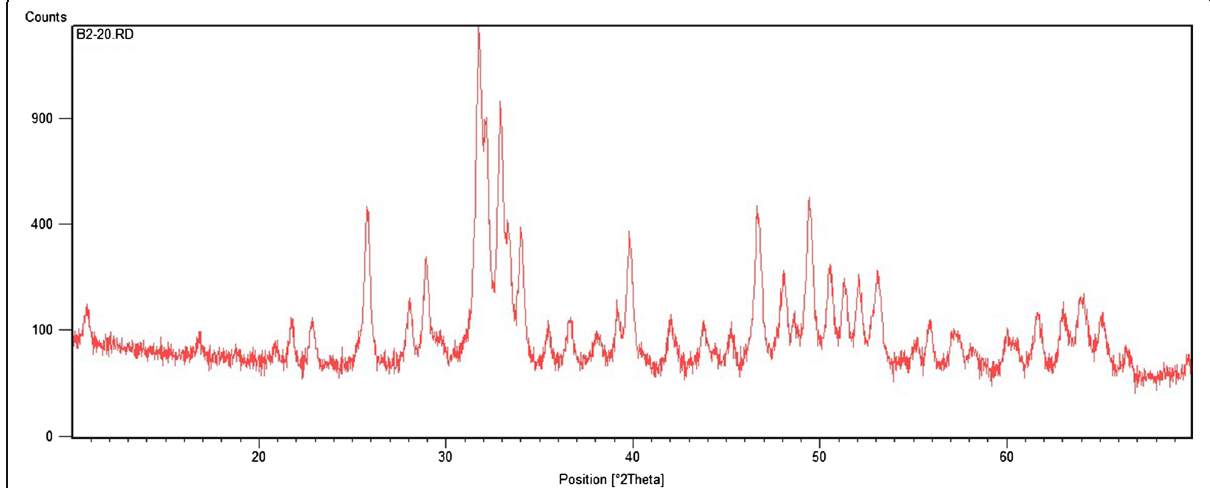
Fig. 1 The XRD spectrum of irradiated sample at 20 kGy presents peaks at 2 θ of 37.81, 44.21, and 63.41, assigned to the diffractions from the (1 1 1), (2 0 0), and (2 2 0) planes of face-centered cubic (fcc) silver